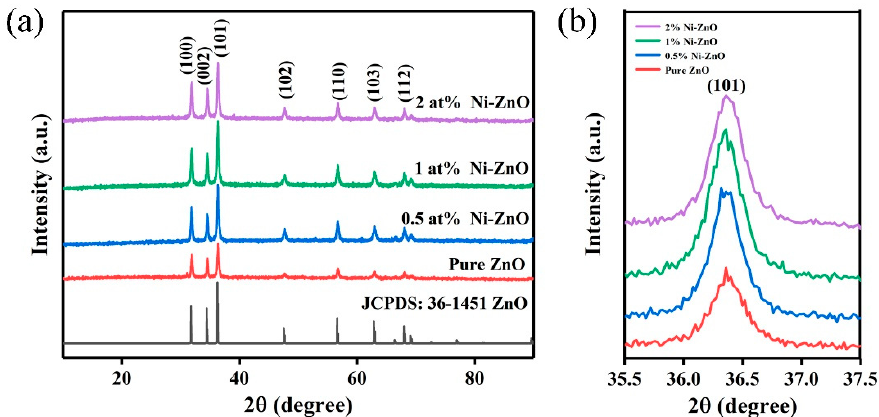
Figure 1. ( a ) The XRD patterns of the pure and Ni–ZnO, ( b ) enlarged spectra of the XRD patterns of the Ni–ZnO. the